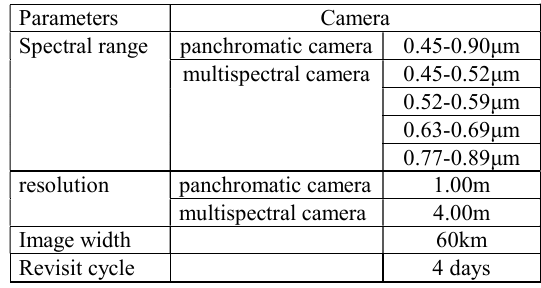
Table 1. Main parameters of Gaofen-2